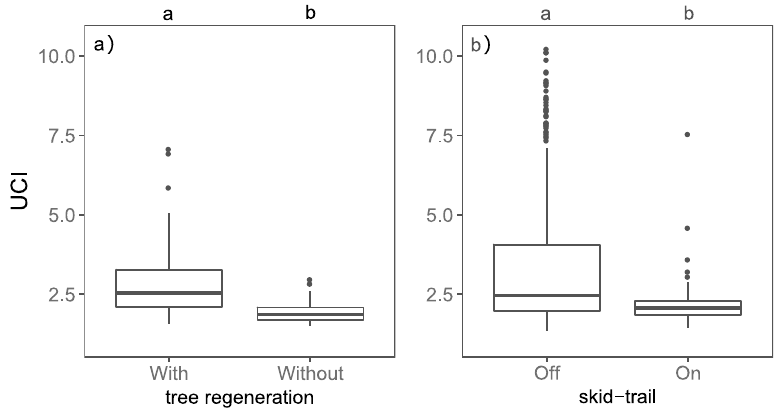
Figure 5. ( a ) Box-and-whisker plots of the understory complexity index (UCI) in dependence of the presence of tree regeneration in the inventory plots. The letters a and b ( p < 0.05) indicate significant differences between samples with and without tree regeneration. Sample sizes: with tree regeneration (n = 27) and without tree regeneration (n = 44). ( b ) Box-and-whisker plots of the understory complexity index (UCI) in dependence of the presence of skid-trails in the managed beech stands. The letters a and b ( p < 0.05) indicate significant differences between samples in which we measured on skid-trails and off skid-trails. Sample sizes: on skid-trails (n = 54) and off skid-trails